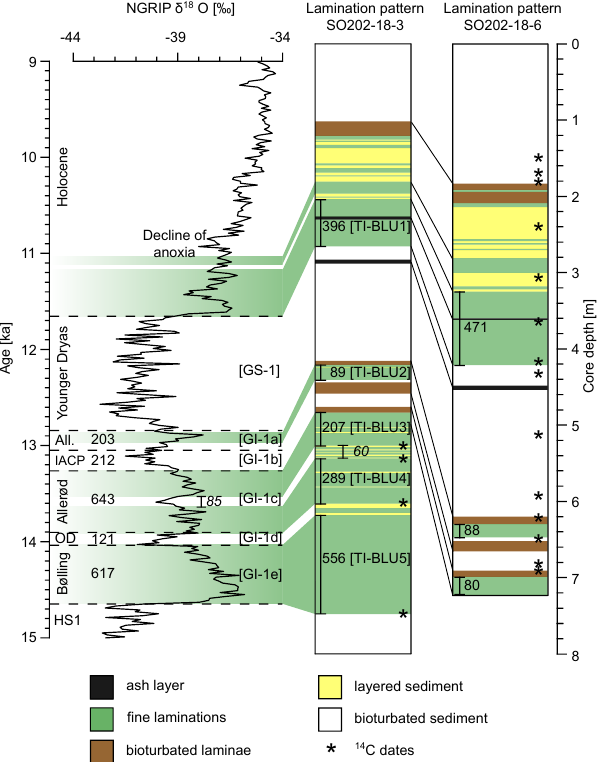
Figure 8. Correlation between lamination pattern in cores SO202-18-3/6 to 20yr average NGRIP ice core data (Rasmussen et al., 2006). Dashed lines and captions on the right side of NGRIP data mark the events according to the GICC05 chronology, and their duration is given with the numerical numbers between the dashed lines. The left side of the stable isotope graph shows the commonly used terminology of the Blytt–Sernander sequence (Mangerud et al., 1974) for comparison. The italic number inside GI-1c gives the duration of a short cold period inside the Allerød that we also identi- fied in our core SO202-18-3. Green colors in the NGRIP data mark warm phases that correspond to the laminated sediment intervals of our sediment cores. On the right side the lamination patterns of SO202-18-3 and SO202-18-6 are shown. Bioturbated Facies are shown in white, Bioturbated Lamination Facies in brown, Layered Facies in yellow, Laminated Facies in green, and ash layers in black. Black lines between both cores mark correlated sediment facies. Laminated sections that were correlated with warm periods in the ice core record are labeled TI-BLU1–5. Asterisk mark 14 C dates, and numbers and vertical black lines inside the lamination patterns give results of laminae counts for the TI-BLU intervals. Addition- ally, laminae countings of a short cold period between TI-BLU4 and TI-BLU3 that was identified during our correlation are given in italic letters (see text for details). Note that thick laminated sections do not occur after 11ka. (All.): Allerød; (IACP): Intra-Allerød Cold Period; (HS1): Heinrich Stadial I; (OD): Older